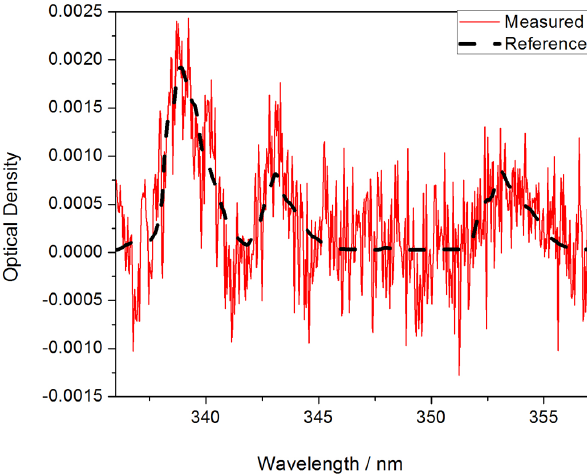
Fig. 4. Example spectral fit for formaldehyde from the MAX-DOAS analysis. The red solid line shows the measured atmospheric spec- trum after all other absorbers have been subtracted, and the dashed line shows the reference spectrum. The fit corresponds to a slant column density of 3 . 31 × 10 16 cm − 2 and is for a solar zenith angle of 59 ◦